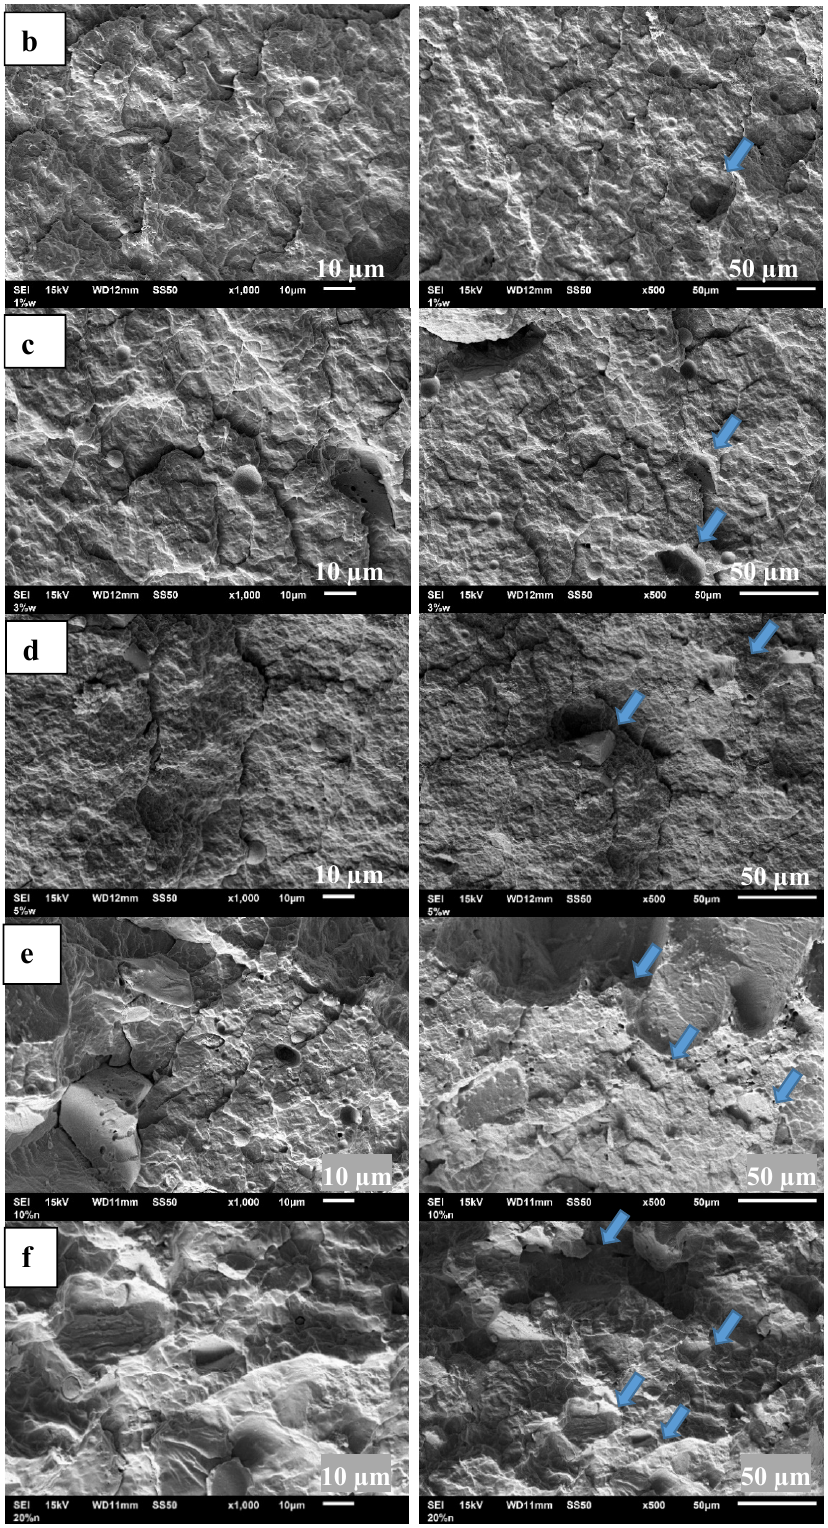
Figure 8. Scanning electron micrograph of: ( a ) PLA / PHB blend, ( b–f ) PLA / PHB / ATBC composites with di ff erent keratin content. Micrographs are labelled according to keratin content, i.e., b , c , d , e , f contain 1, 3, 5, 10 and 20 wt % of keratin, respectively. SEM images were taken at 500 × ( right side ) and at 1000 × ( left side ) magnification. Arrows in the left micrographs show some of the visible aggregates of the